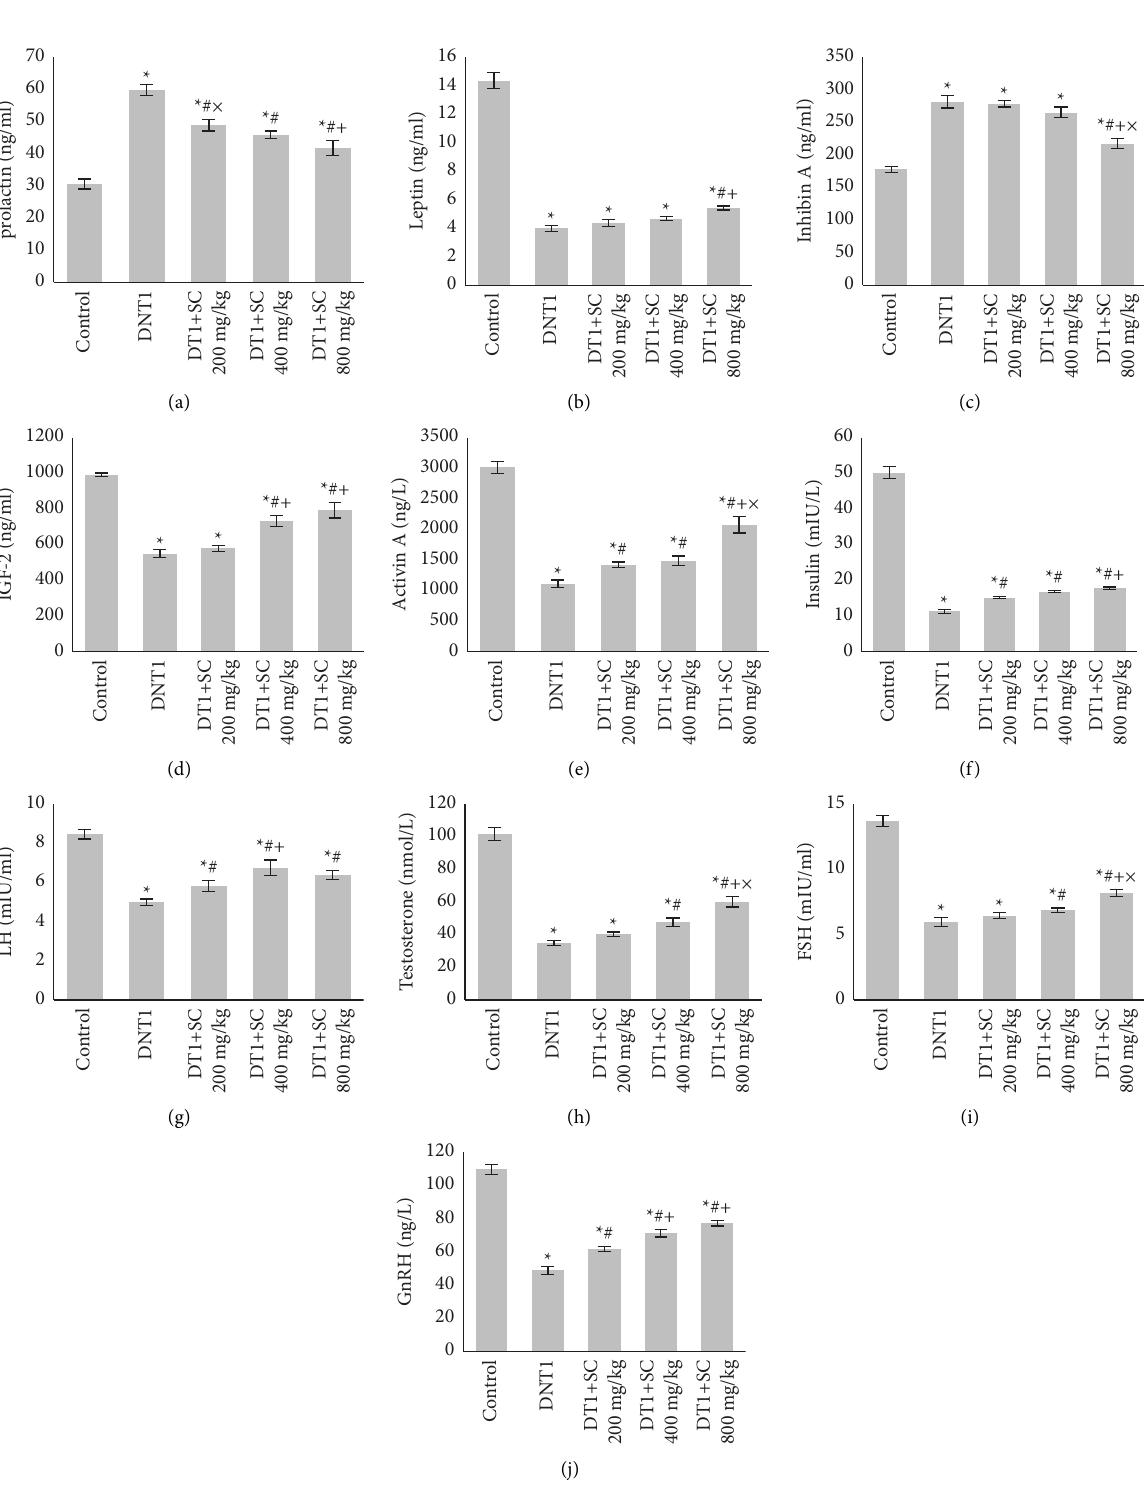
Figure 2: Blood prolactin, leptin, inhibin A IGF-2, activin A insulin, LH, testosterone, FSH, and GnRH levels. (a) Mean prolactin level, (b) mean leptin, (b) inhibin A, (c) IGF-2, (d) activin A, (e) insulin, (f) LH, (h): testosterone, (i) FSH, and (j) GnRH. Significant differences at p value < 0.05 are shown as not having a common character. Values are shown as mean ± SEM. ns: nonsignificant between groups, hashtag sign (#): difference with DNT1, plus sign (+): difference with DT1 +SC200mg, multiplication sign ( × ): difference with DT1+SC400